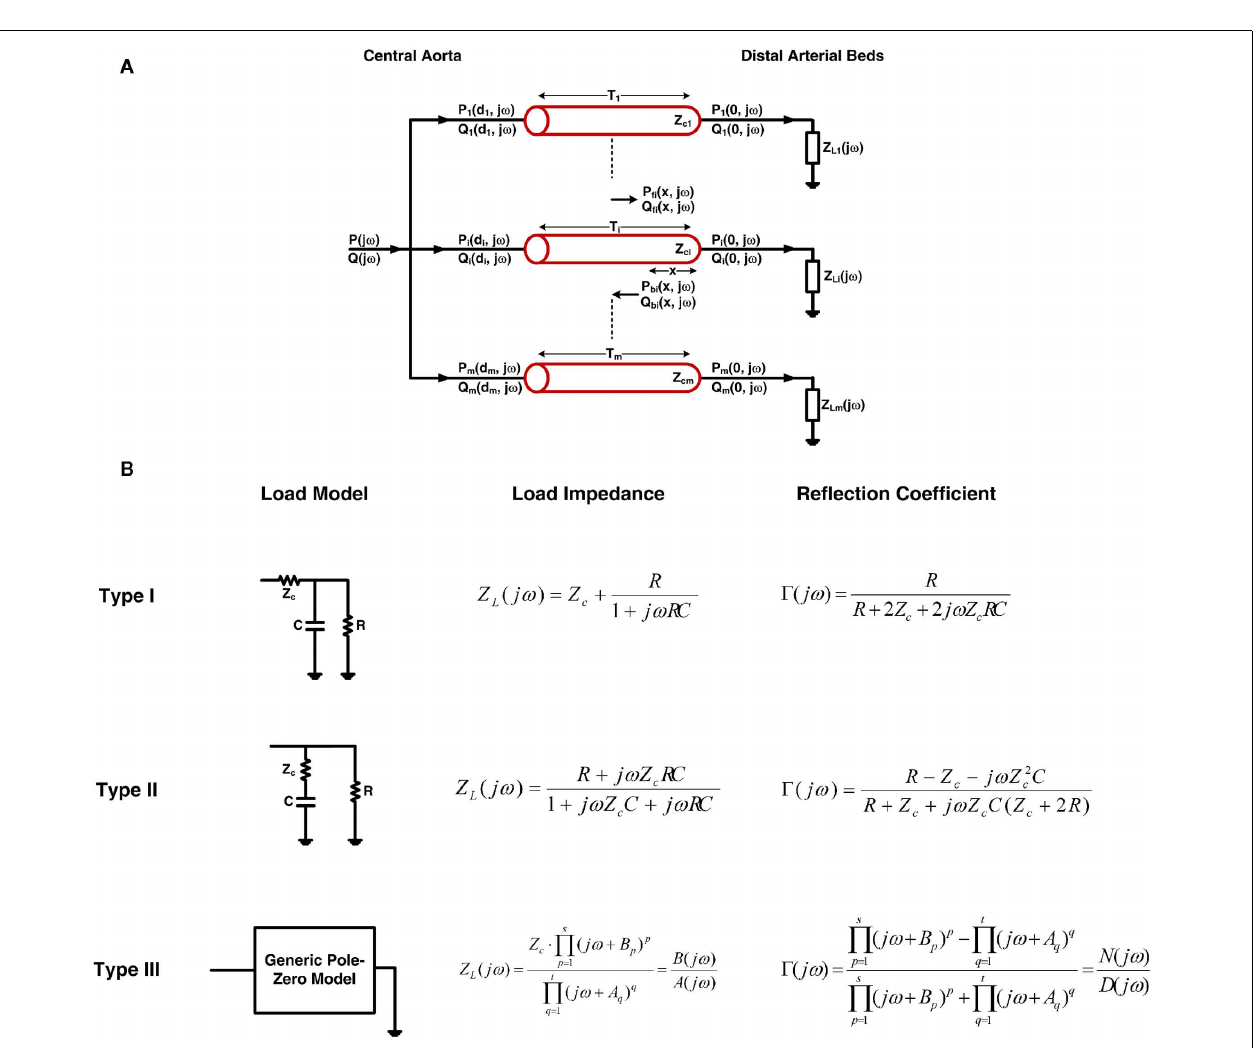
FIGURE 1 | (A) The tube-load model with arbitrary load. (B) Three types of commonly used loads along with their corresponding impedances and reflection coefficients. See text for complete model details.